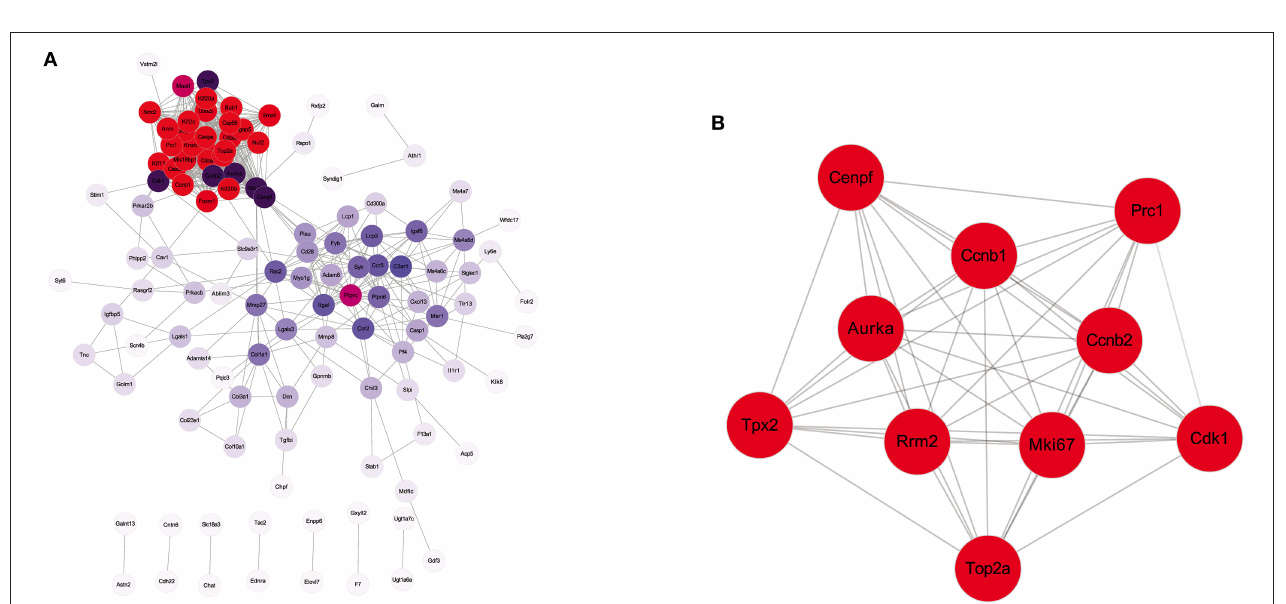
FIGURE 4 | Kyoto Encyclopedia of Genes and Genomes (KEGG) pathway enrichment analysis between EA and control group. Bubble plots showing the top 20 significant pathways of DEGs. Larger bubbles illustrated higher number of genes. The color of each bubble represents the varied p -value. n = 3 mice/group.